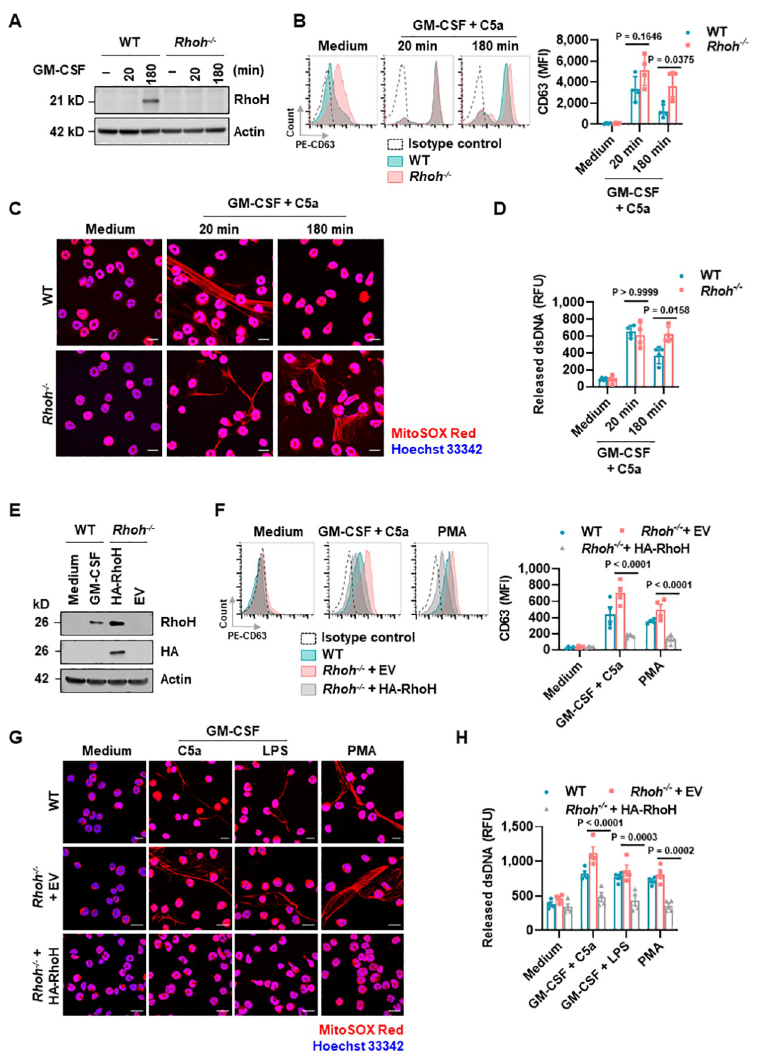
Fig 2. Induction of RhoH expression by GM-CSF stimulation or overexpression of HA-RhoH impairs neutrophil degranulation and dsDNA release. ( A ) Neutrophils purified from bone marrow of WT and Rhoh -/- mice were incubated with GM-CSF for the indicated times followed by immunoblotting. ( B – D ) Neutrophils from WT and Rhoh -/- were pretreated with GM-CSF for the indicated times followed by activation with C5a for 15 min. ( B ) Neutrophil degranulation was determined by flow cytometry. ( C ) Extracellular DNA fibers were analyzed by confocal microscopy. Scale bars, 10 μ m. ( D ) Quantification of released dsDNA in the culture supernatants. ( E ) Expression of RhoH in the indicated HoxB8 neutrophils was analyzed by immunoblotting. ( F – H ) Mature HoxB8 neutrophils were treated with the indicated stimuli. ( F ) Neutrophil degranulation was determined by flow cytometry. ( G ) Extracellular DNA fibers were analyzed by confocal microscopy. Scale bars, 10 μ m. ( H ) Quantification of released dsDNA in culture supernatants. ( A, C, E, G ) Similar results were obtained from 3 independent experiments. ( B, D, F, H ) Each symbol represents a single experiment. Values are means ± SD. ( B, D ) Two-way ANOVA with Tukey’s multiple comparisons test. ( F, H ) Two-way ANOVA with Sˇı´da´k’s multiple comparisons test. The underlying data for Fig 2B, 2D, 2F, and 2H can be found in S1 Data. The underlying data for Fig 2A and 2E can be found in S1 Raw images. dsDNA, double- stranded DNA; GM-CSF, granulocyte/macrophage colony-stimulating factor; WT,